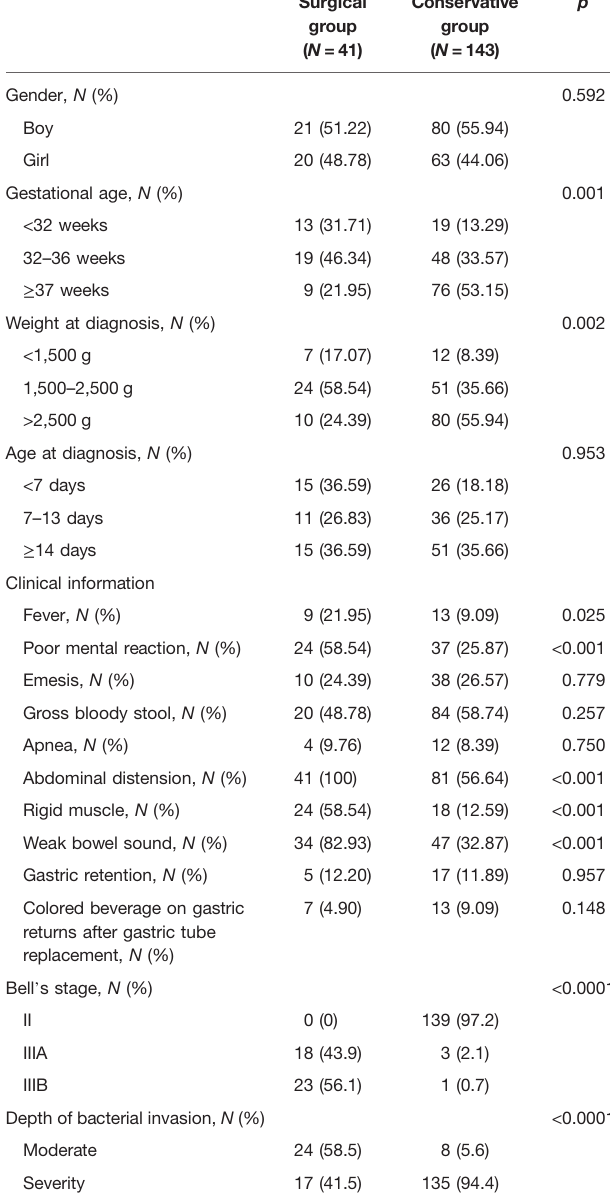
TABLE 1 | Patients ’ characteristics between surgical group and conservative group.